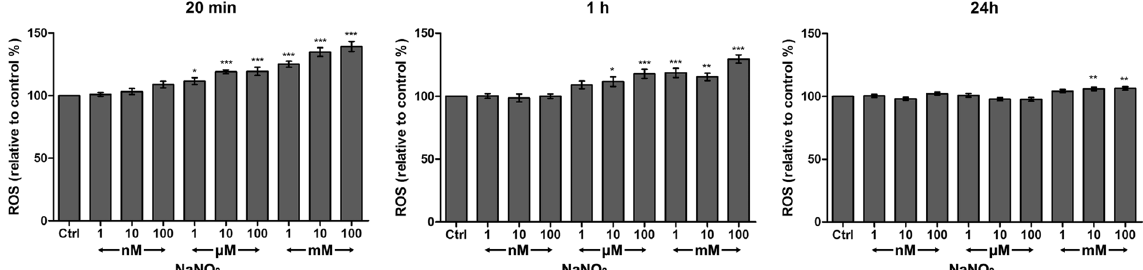
Figure 2. Induced ROS in HCECs following treatment with different concentrations of NaNO 2 . We found that ROS increased dose-dependently with the addition of NO. The effect was most prominent at 20 min after addition of NaNO 2 . Values are presented as means ± SEM (n = 3) and are calculated as a percentage of negative control (0 μ g/mL treated groups); P values were calculated compared to negative control. * p < 0.05, ** p < 0.01, *** p < 0.001.